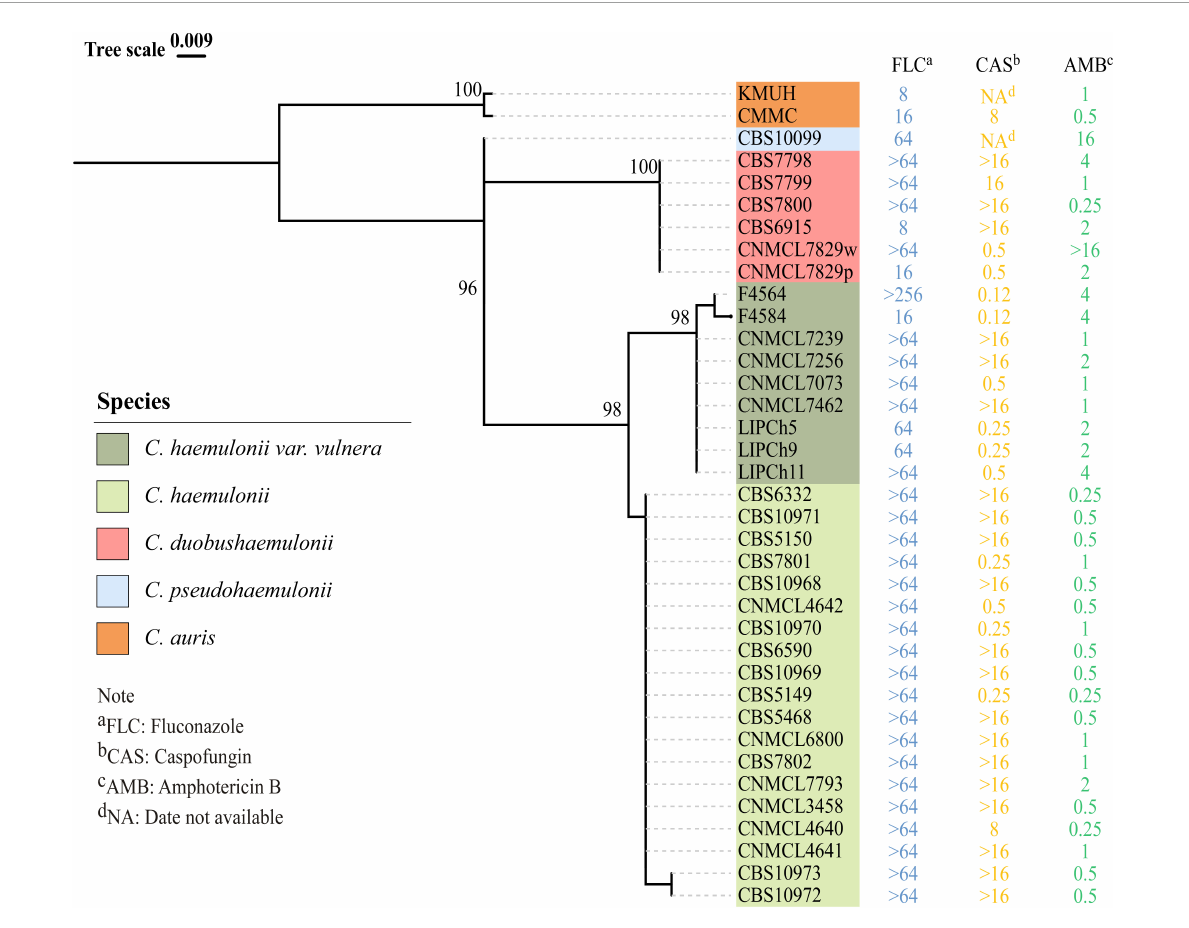
FIGURE2 Phylogenetic tree for rDNA ITS region of previously reported Candida haemulonii , C . duobushaemulonii , C . pseudohaemulonii , C . auris , and C . haemulonii var. vulnera , including two C . haemulonii var . vulnera clinical strains identified in this study. Phylogenetic tree was constructed using Mega X with 1000 bootstrap replicates based on the maximum likelihood